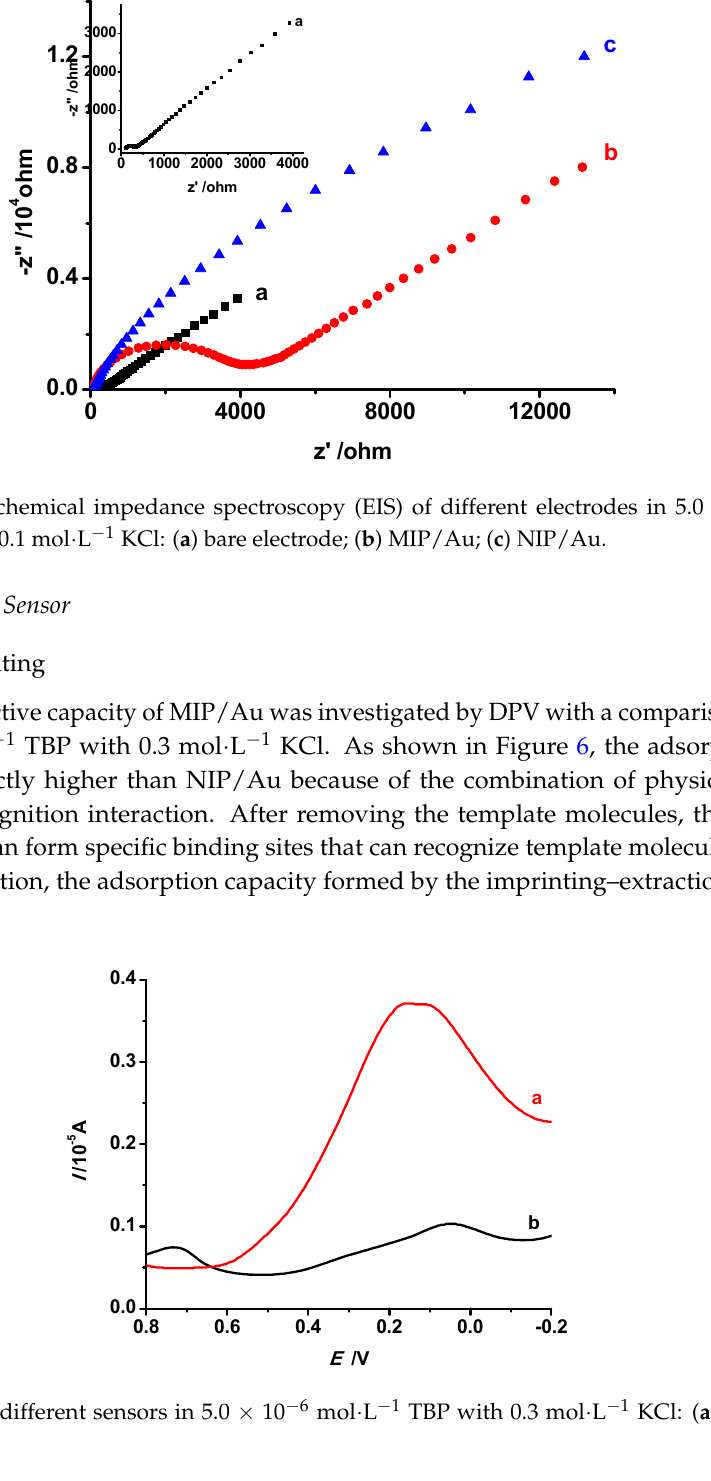
Figure 6. DPV of different sensors in 5.0 × 10 − 6 mol·L − 1 TBP with 0.3 mol·L − 1 KCl: ( a ) MIP/Au; ( b ) NIP/Au.